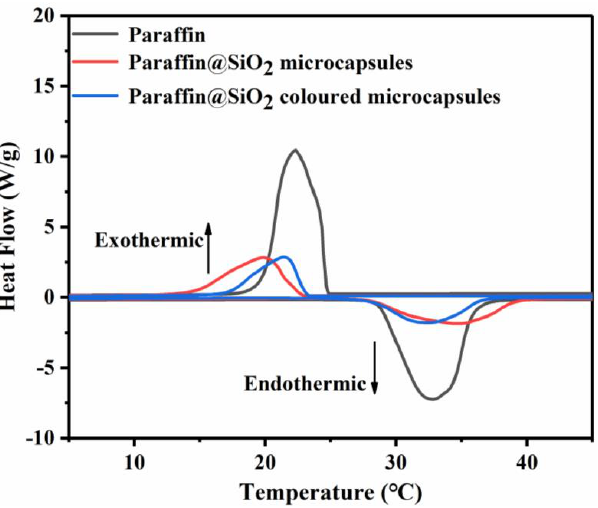
Figure 9. DSC of pristine paraffin, paraffin@SiO 2 microcapsules, the paraffin@SiO 2 colored micro- capsules. Table 4. Phase change properties of pristine paraffin and the obtained microcapsules. Crystallization Process Samples